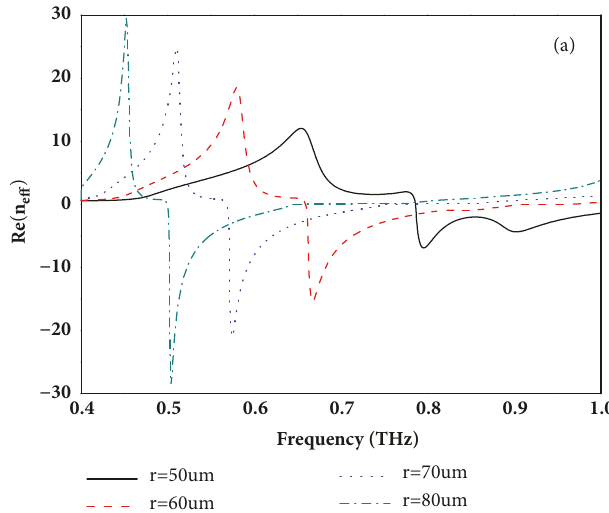
Figure 4: The real part of 𝑛 𝑒𝑓𝑓 as a function of the radius of the dielectric sphere, where 𝑓 = 0.2 and 𝑇 = 220 K.